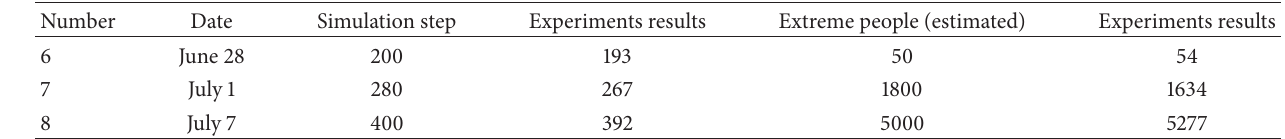
Table 6: Derivative events in the case incident.